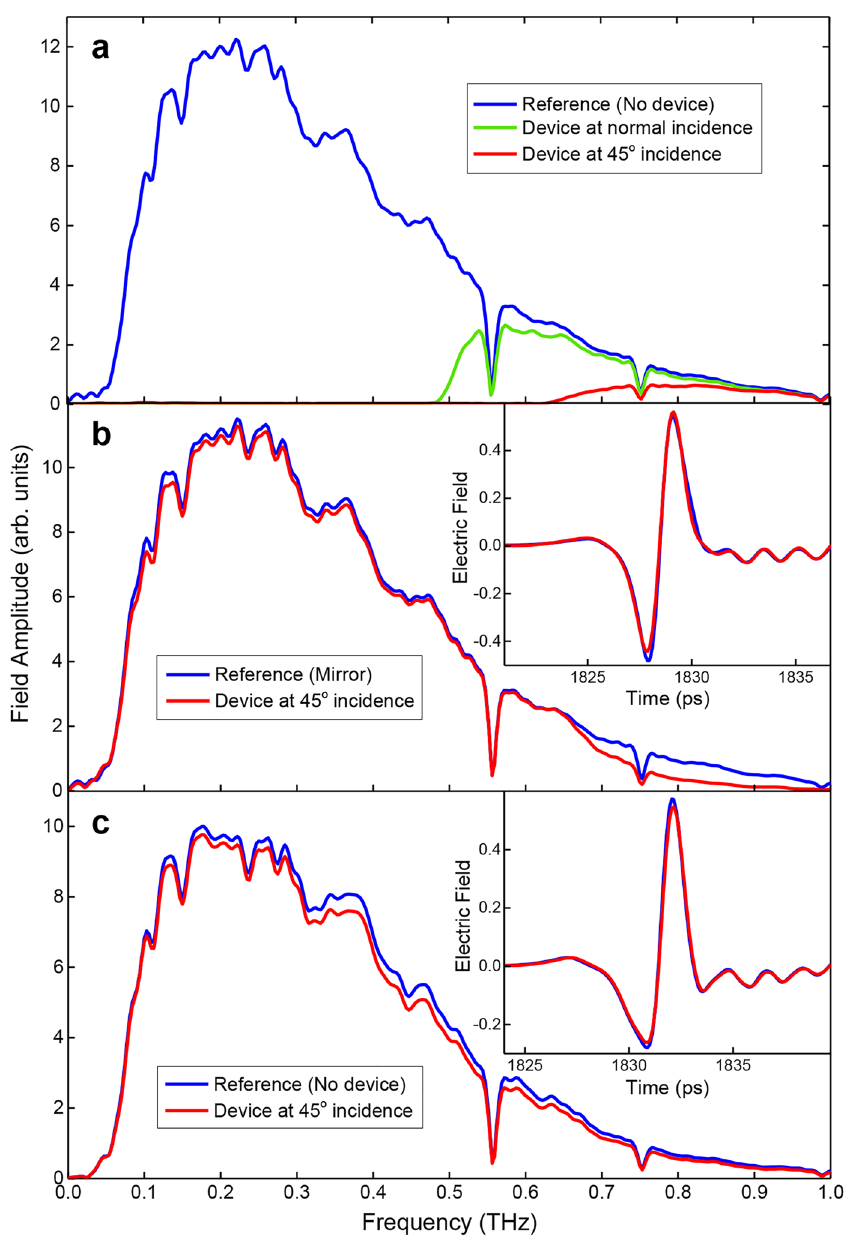
Figure 3. Transmission and reflection spectra. ( a ) Transmission spectra when the input polarization is parallel to the plates. The blue curve is the reference with no device, the green curve is with the device at normal incidence, and the red curve is with the device at 45° incidence. The device spectra correspond to TE 1 -mode propagation through the device. The sharp dips at 0.56 THz and 0.75 THz are due to water-vapor absorption. ( b ) Reflection spectra when the input polarization is parallel to the plates. The red curve is with the device at 45° incidence and the blue curve is the reference with a polished aluminum mirror replacing the device. ( c ) Transmission spectra when the input polarization is perpendicular to the plates. The blue curve is the reference with no device and the red curve is with the device at 45° incidence. The device spectrum corresponds to TEM- mode propagation through the device. The insets in ( b ) and ( c ) show the corresponding time-domain